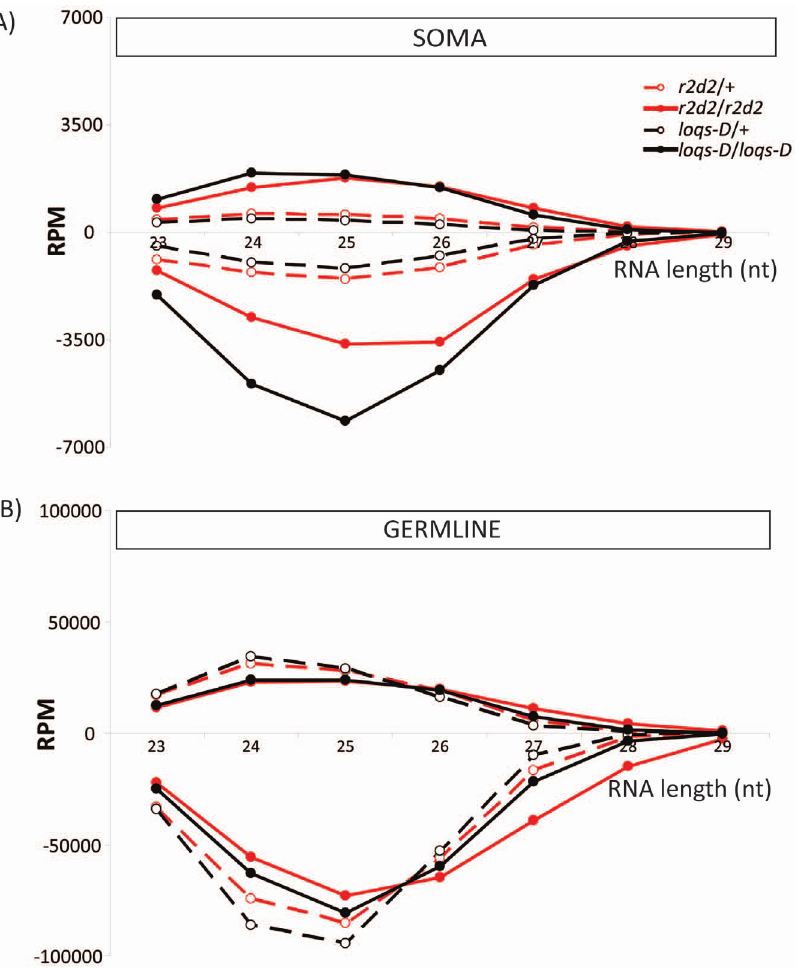
Figure 6. Orientation bias for pilRNAs in soma and piRNAs in germline. Small RNA libraries generated with b -eliminated RNA samples were mapped to the transposon sequence collection. The RPM for sense ( + ) and antisense (–) transposon matching small RNAs for 23 nt to 29 nt were depicted for soma (A) and germline (B) to demonstrate the orientation bias. Note that the apparent increase of somatic pilRNAs is due to the removal of certain miRNAs and endo-siRNAs in homozygous mutants, which are either less efficiently produced and/or mis-directed into Ago1. Upon b - elimination, these RNAs no longer contribute to the sequenced pool, hence other RNA classes appear to be more abundant. We did not observe this increase if untreated libraries were